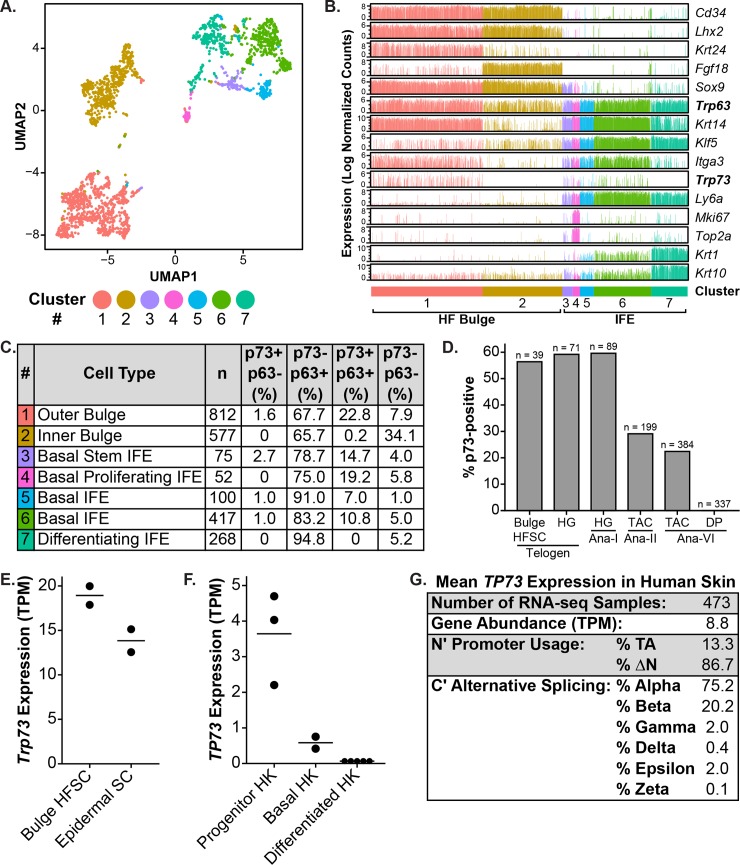
Analysis of p73 expression in epidermal and HF stem cells using transcriptomic data sets.(A) UMAP (Uniform Manifold Approximation and Projection) plot of 2310 murine keratinocyte (back skin) single cell transcriptomes from the Tabula Muris dataset [40]. Each dot represents an individual cell and is colored according to cluster membership. (B) Bar graphs of RNA expression for keratinocyte cell type markers from (A). Each bar represents one cell and is colored by cluster number from (A). (C) Table summarizing Trp73 and Trp63 expression and co-expression in single murine keratinocyte cells from (A) by cluster number. Each cluster number is annotated with: the primary cell type of the cluster (based on cell type marker expression), the number (n) of cells belonging to the cluster, and the percentage of cells with each p73/p63 expression status. (D) Bar graph of the percentage of p73-positive cells in different classes of murine HF cells by single-cell RNA-seq (scRNA-seq) [44]. Hair cycle stages include: telogen, anagen I (Ana-I), anagen II (Ana-II), and anagen VI (Ana-VI). Cell types include: bulge HF stem cells (HFSC), hair germ (HG) cells, transit-amplifying cells (TAC), and dermal papilla (DP) cells. The number of cells analyzed for each cell type is listed above each bar. (E) Dot plot of Trp73 expression (TPM) in murine bulge HFSC and epidermal stem cells (SC) by bulk RNA-seq [45]. Cells were isolated by fluorescence-activated cell sorting (FACS) with marker-based sorting. Horizontal lines represent the mean. (F) Dot plot of TP73 expression (TPM) in primary human keratinocytes (HK) grown and differentiated in vitro for 6 or 7 days [46,47]. HKs were enriched for progenitors based on rapid collagen IV adherence. Horizontal lines represent the mean. (G) Table with the mean TP73 isoform expression in human skin (lower leg) RNA-seq samples (n = 473) from the Genotype-Tissue Expression (GTEx) Project [48,49]. For each sample, total gene abundance (TPM), N-terminal promoter usage, and C-terminal alternative splicing was calculated and is shown. See also S1 Table.